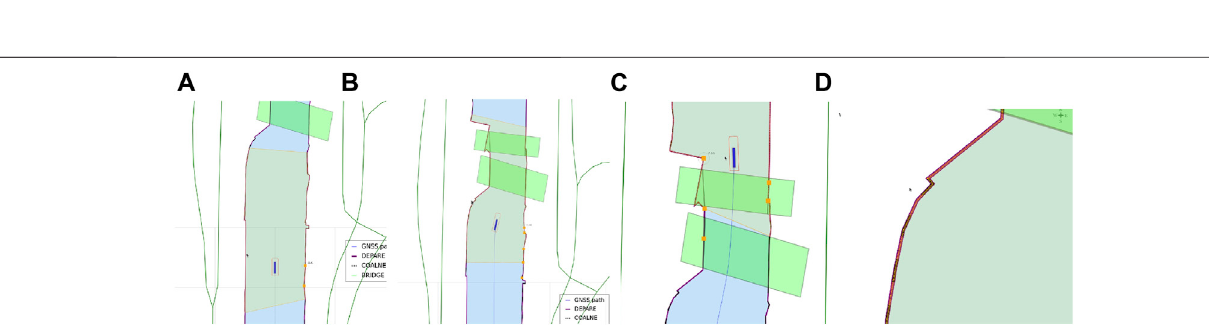
Frontiers in Robotics and AI |